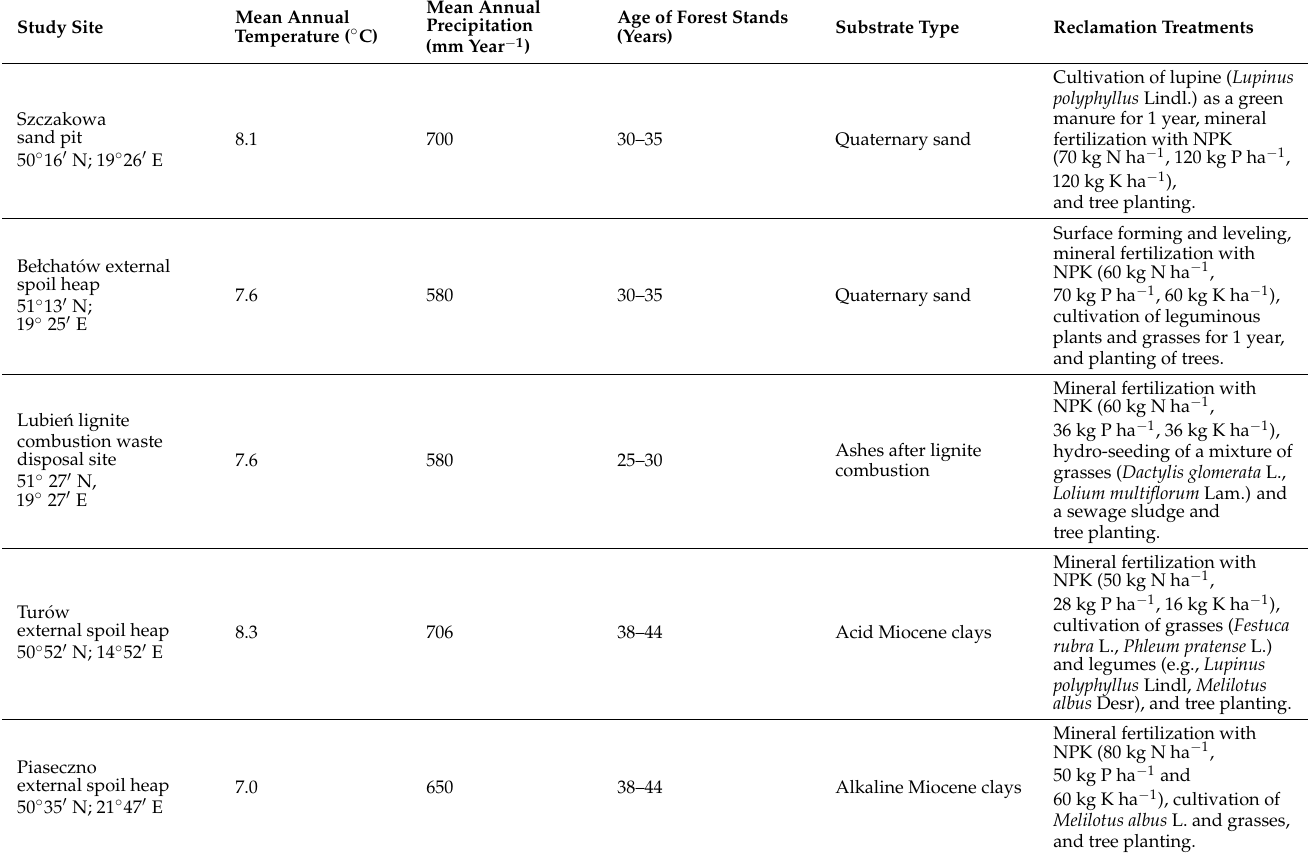
Table 1. Basic characteristics of the experimental